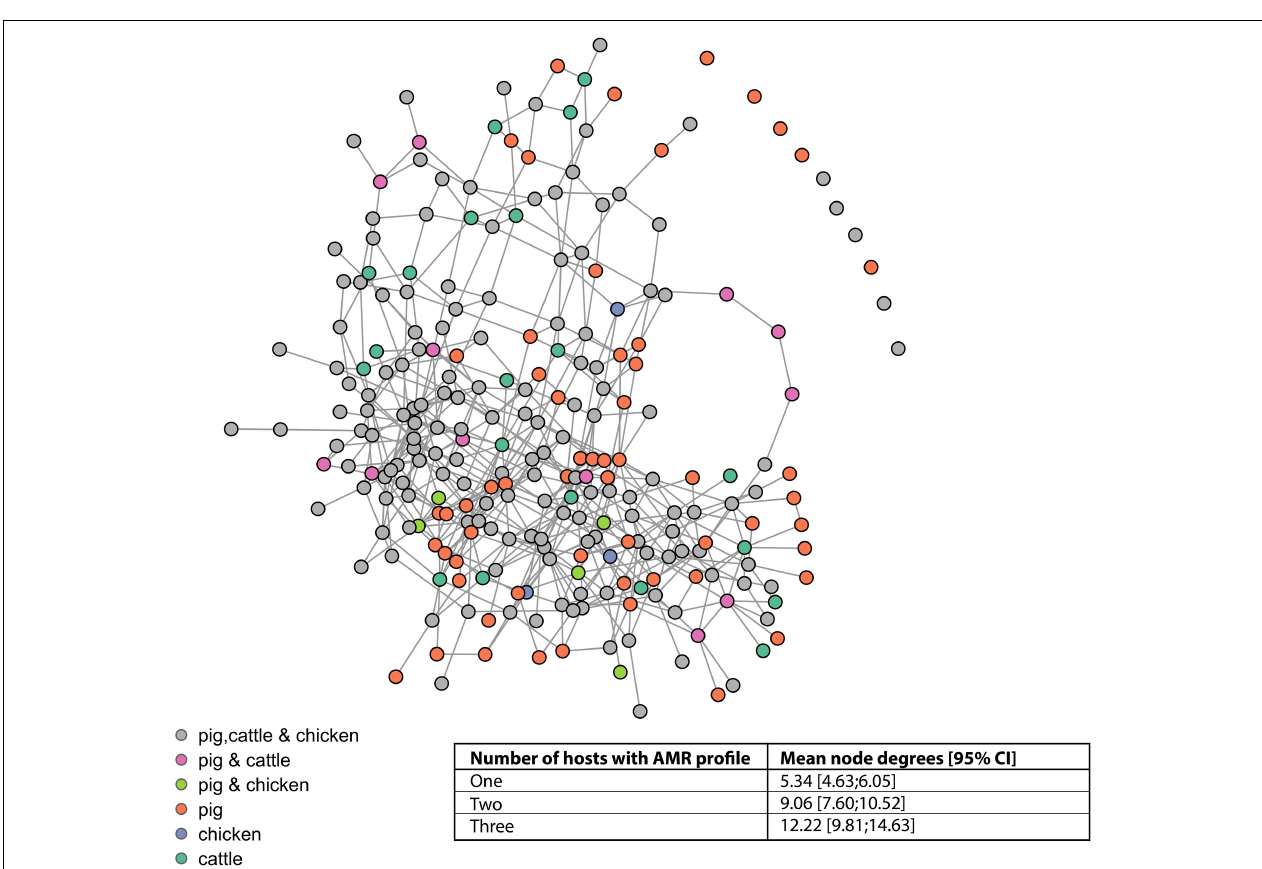
FIGURE 5 | Network connectivity diagram of phenotypic antimicrobial resistance profiles. Nodes represent phenotypic antimicrobial resistance profiles. Edges represent loss or acquisition of resistance to a single antimicrobial. Inset table: mean node degrees and betweenness scores for AMR profiles observed in one, two, or three host